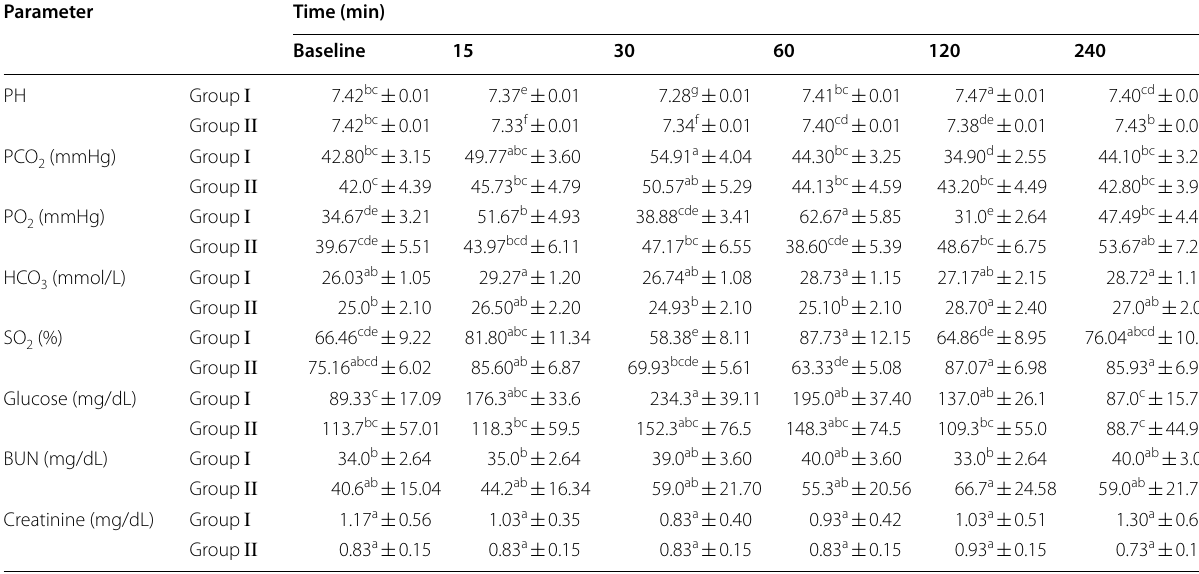
Table 3 Mean standard deviation (SD) of hematobiochemical parameters at different time intervals ±